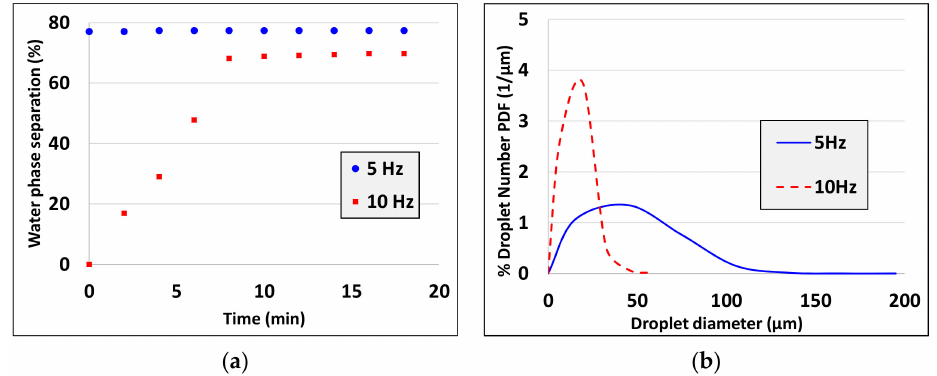
Figure 8. E ff ect of stroke frequency f on ( a ) water phase separation and ( b ) droplet size distribution of emulsions (C SDS = 10 CMC, ϕ = 0.2 and t n = 0.5 min; Piston 1, 5 Hz: d av = 45 µ m, 10 Hz: d av = 14.6 µ m,